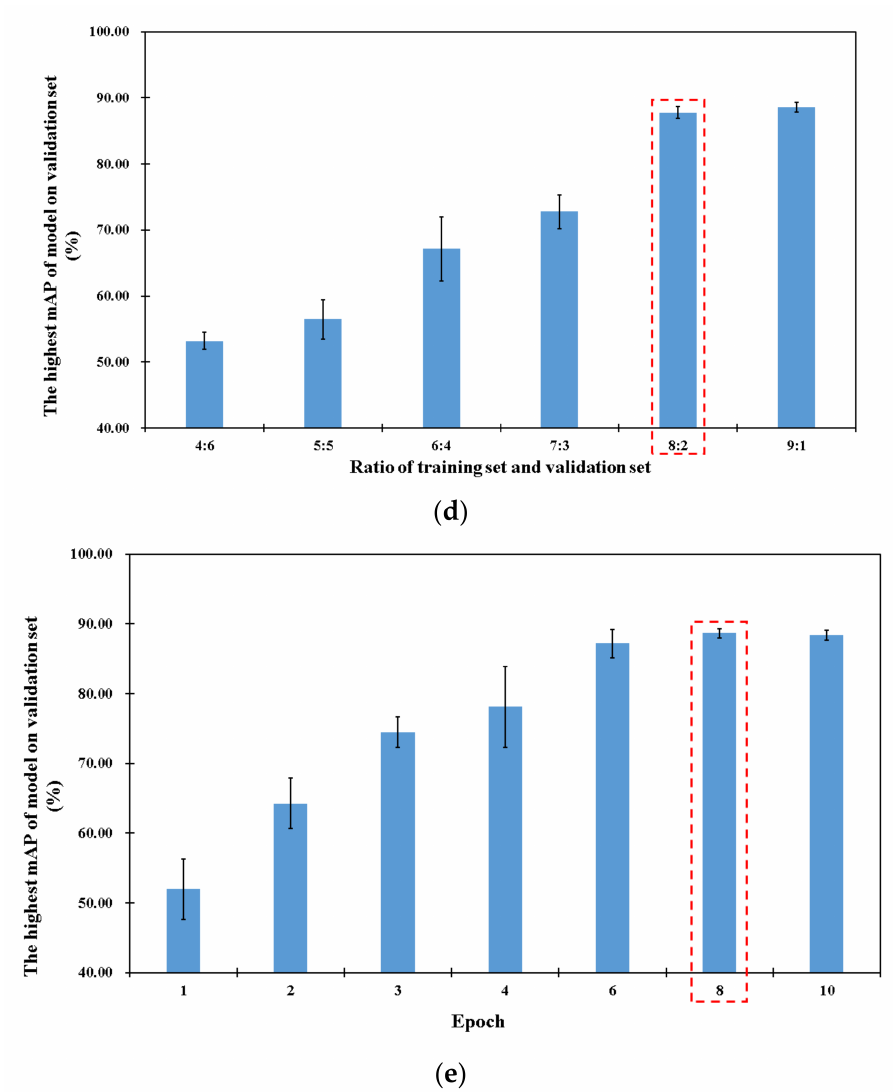
Figure 3. Comparison of faster R-CNN algorithm with contour counting method. ( a ) Comparison of the counting results between faster R-CNN based on deep learning and contour counting based on thresholds for fluorescent images at the concentration of 1.1 × 10 3 CFU/mL. ( b ) The counting situation of contour counting method on fluorescent images. ( c ) The counting situation of faster R-CNN on fluorescent images. ( d ) Optimization of the ratio of the training set to the validation set. ( e ) Optimization of the training